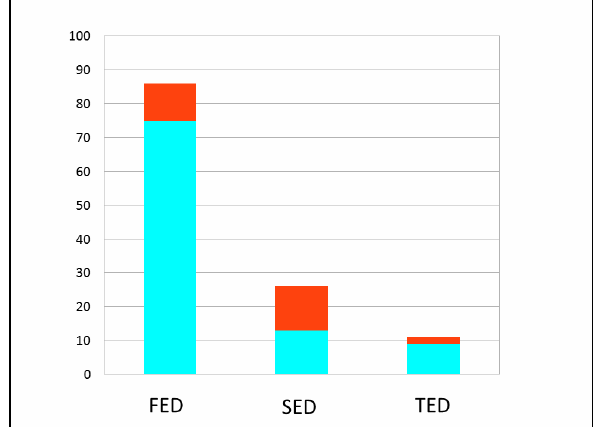
Figure 5. Results In The Course